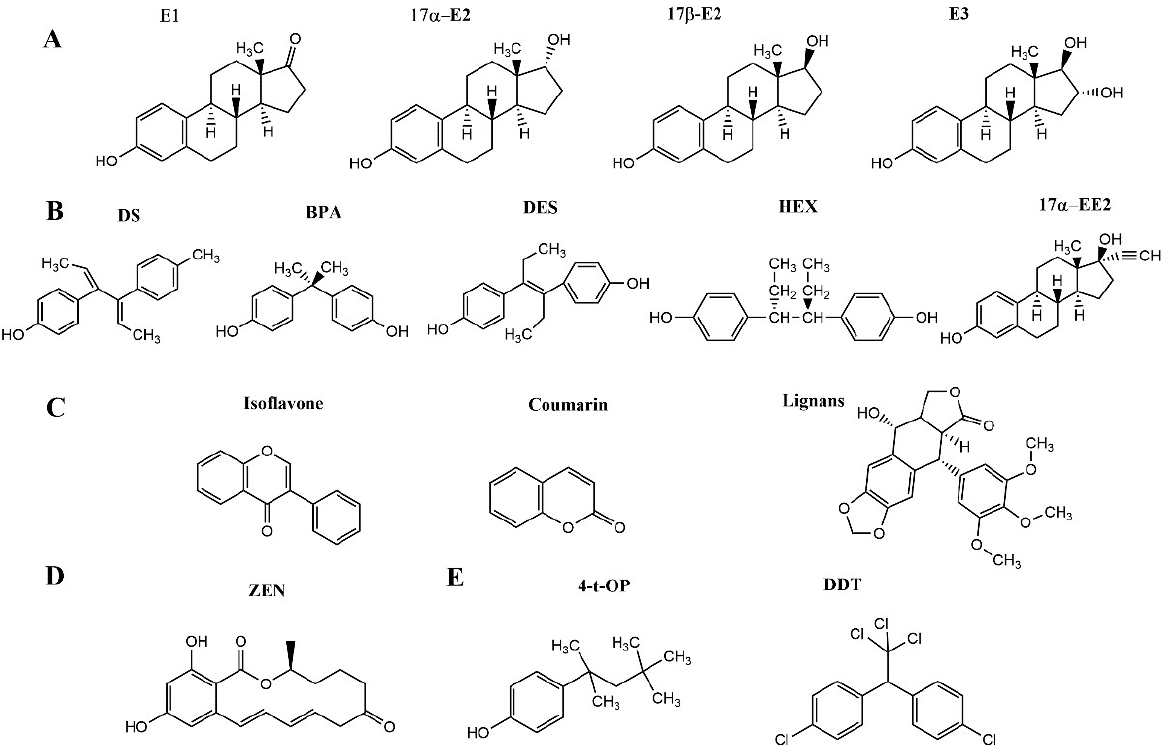
Figure 1. Chemical structures of different kinds of e-EDCs. ( A ): Endogenous natural estrogens. E1, estrone; 17α-E2, 17α-estradiol; 17β-E2, 17β-estradiol; E3, estriol. ( B ): Synthetic estrogens. DS, dienes- gens. E1, estrone; 17 α -E2, 17 α -estradiol; 17 β -E2, 17 β -estradiol; E3, estriol. ( B ): Synthetic estro- trol; BPA, bisphenol A; DES, diethylstilbestrol; HEX, hexestrol; 17α-EE2,17α-ethynyl estradiol. ( C ): gens. DS, dienestrol; BPA, bisphenol A; DES, diethylstilbestrol; HEX, hexestrol; 17 α -EE2,17 α - Phytoestrogens. Isoflavones; Coumarins; Lignans. ( D ): Estrogen-active mycotoxins. ZEN, zeara- ethynyl estradiol. ( C ): Phytoestrogens. Isoflavones; Coumarins; Lignans. ( D ): Estrogen-active lenone. ( E ): Alkylphenols. 4-t-OP, 4-tert-octylphenol. Other chemicals. DDT, dichlorodiphenyltri- mycotoxins. ZEN, zearalenone. ( E ): Alkylphenols. 4-t-OP, 4-tert-octylphenol. Other chemicals. chloroethane. DDT,